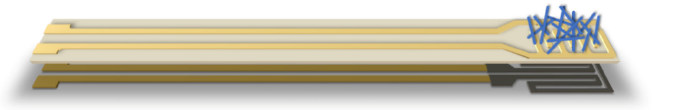
Figure 1. Al 2 O 3 substrate with β -Ga 2 O 3 nanowires grown on Au interdigitated electrodes. Pt meander-type heater was screen printed on the bottom side of the substrate.